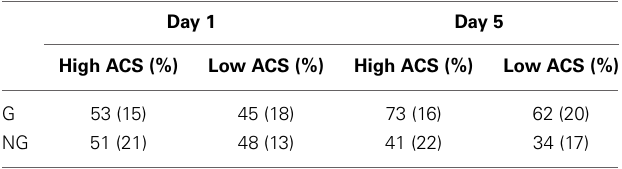
Table 1 | Endorsement rates over grammaticality and local subsequence familiarity (ACS) for day 1 and day 5.